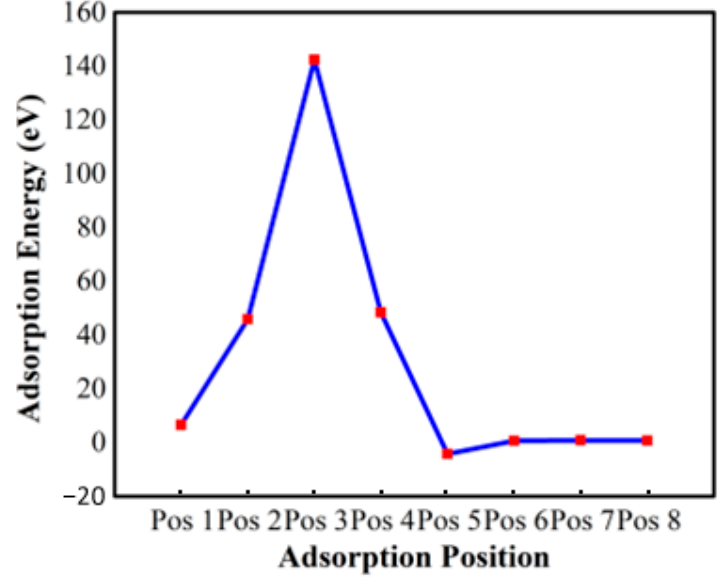
Figure 4. Adsorption energy as a function of the adsorption location.